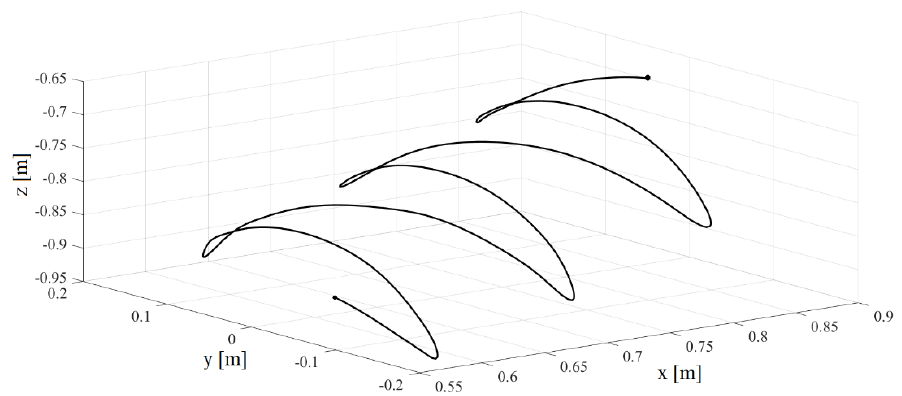
Figure 10. A trajectory of movement of the MM working tool over the object surface.